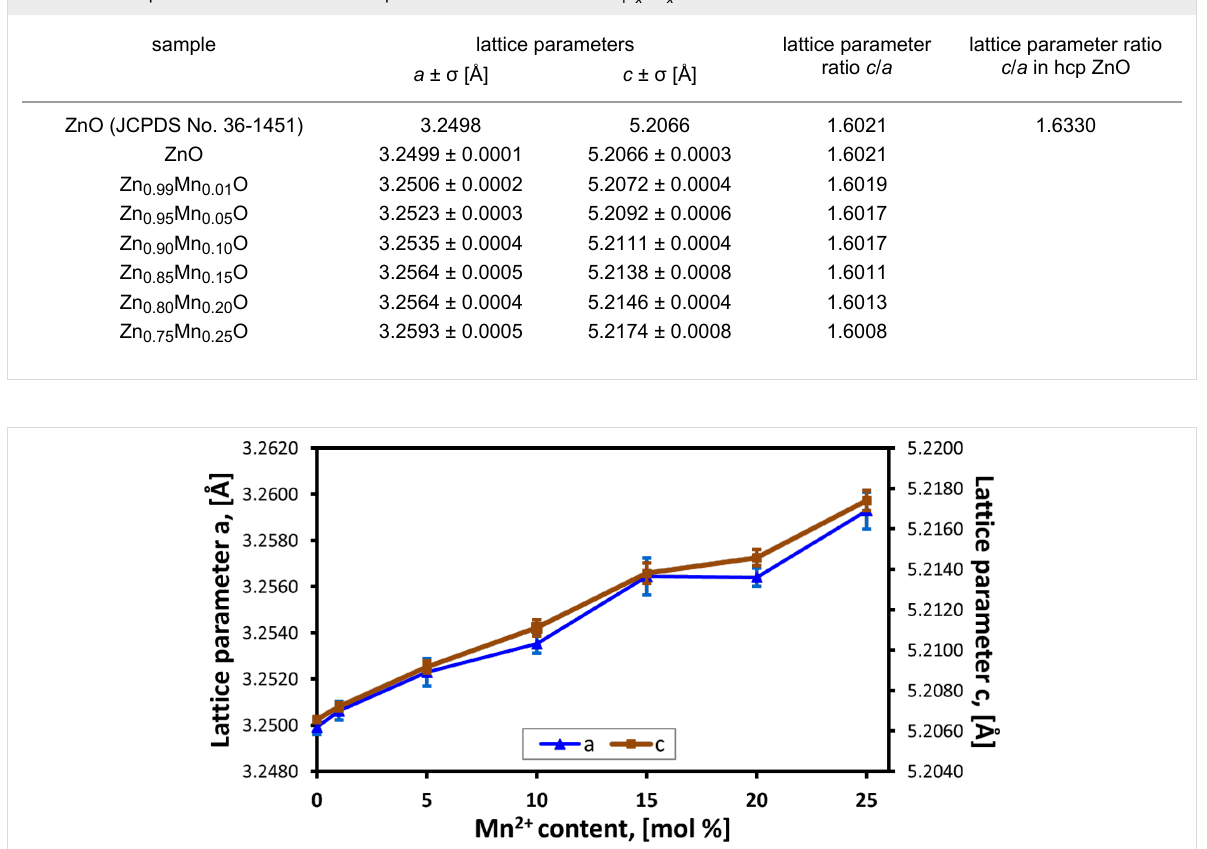
Figure 6: Lattice parameters versus nominal Mn 2+ content of Zn 1 − x Mn x O samples.